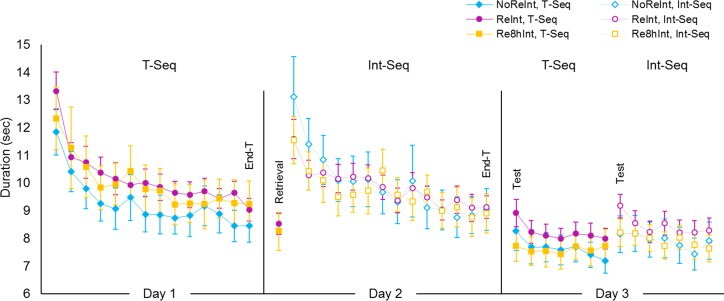
Performance rate.Time (i.e., duration) to complete the last 30 key-presses for each performance block during the training (Day 1), retrieval (Day 2) and test (Day 3) of the trained sequence (T-Seq, filled markers) as well as during the training (Day 2) and test (Day 3) of the interference sequence (Int-Seq, empty markers) is plotted for the NoReInt, ReInt and Re8hInt group (blue, magenta and yellow markers, respectively). Last training blocks, the retrieval block and first test blocks are time-points of interest (End-T, Retrieval and Test respectively). Bars–standard error of the mean (s.e.m.).